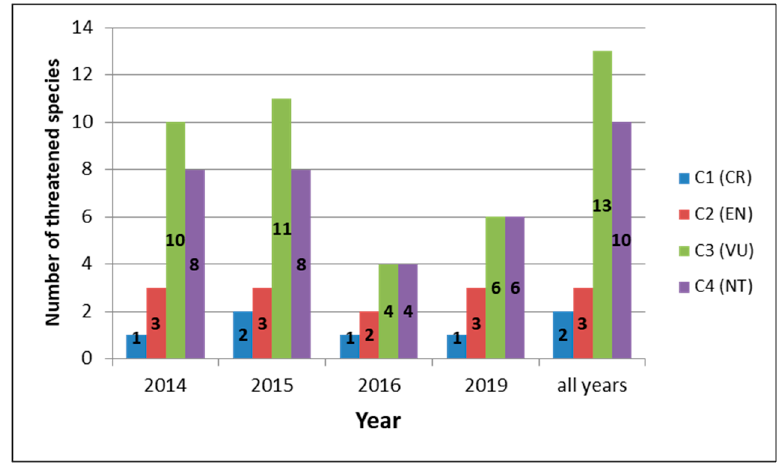
Figure 4. Numbers of threatened species in individual years and within the whole period of the Dehtá ř research. Four basic threat categories according to the Czech Red Data List, along with their international equivalents, were considered.